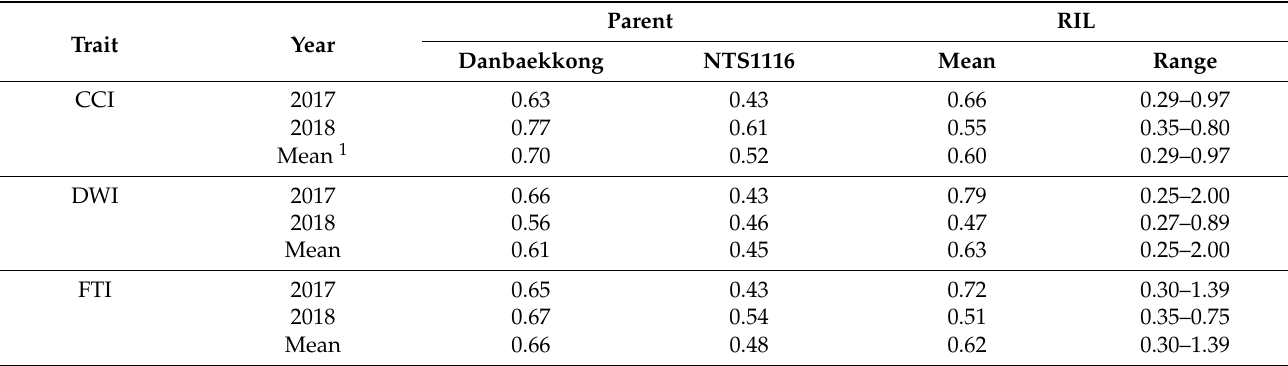
Table 2. Leaf chlorophyll content index (CCI), shoot dry weight index (DWI), and flooding tolerance index (FTI) of parents (‘Danbaekkong’ and ‘NTS1116’) and recombinant inbred lines over two years. Trait